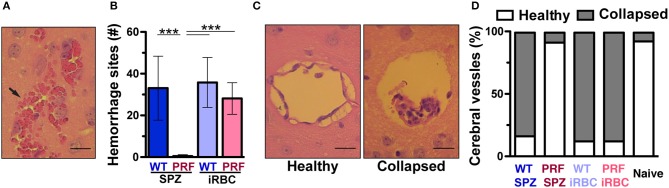
Cerebral vessels from mice infected by PRF sporozoites maintain a healthy status. (A) Hematoxilin and eosin (H&E) stain of a brain tissue section from an animal displaying signature ECM symptoms. An arrow indicates RBCs that leaked into the cerebral parenchyma. Scale bar, 10 μm. (B) Quantification of hemorrhage sites based on H&E stains of horizontal cross-sections of the brain (n = 10 each). Results represent mean values (±SD) from at least two independent experiments. ***P < 0.001 (Mann-Whitney test). (C) Visualization of brain vessel integrity. Shown are H&E stains of representative brain histological cross-sections. Comparison of a healthy vessel (left) from a mouse infected with PRF sporozoites and a collapsed vessel (right) from a mouse infected with WT sporozoites. The latter vessel also contains accumulated leukocytes. Scale bar, 10 μm. (D) Morphological scoring of cerebral vessels based on histological sections. Quantification of mice infected with 5,000 WT sporozoites, PRF sporozoites, WT iRBCs or PRF iRBCs (n = 10 animals for infected groups, n = 3 mice for naïve group; >20 cerebral vessels were quantified for each animal).